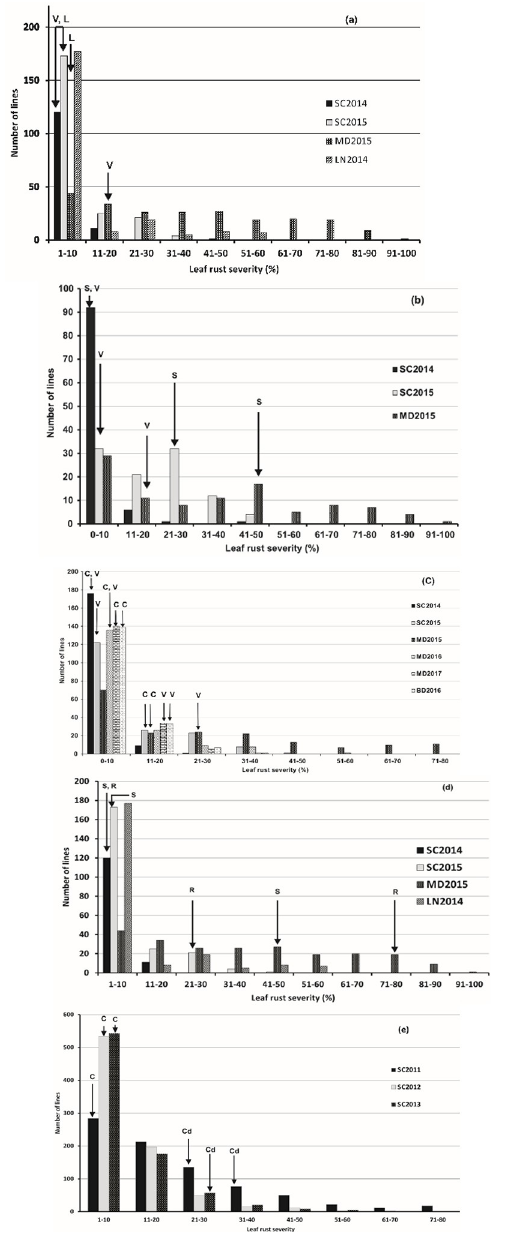
Fig 1. Frequency distribution of five doubled populations (a) Vesper/Lillian, (b) Vesper/Stettler, (c) Carberry/ Vesper, (d) Stettler/Red Fife, and (e) Carberry/AC Cadillac for adult plant leaf rust severity. Arrows indicate parent leaf rust severity: C, Carberry; Cd, AC Cadillac; V, Vesper; L, Lillian; S, Stettler; Rf, Red Fife. In the key, the test year is preceded by the location defined as follows: SC, Swift Current, MD, Morden, Canada, and LN, Lincoln, New